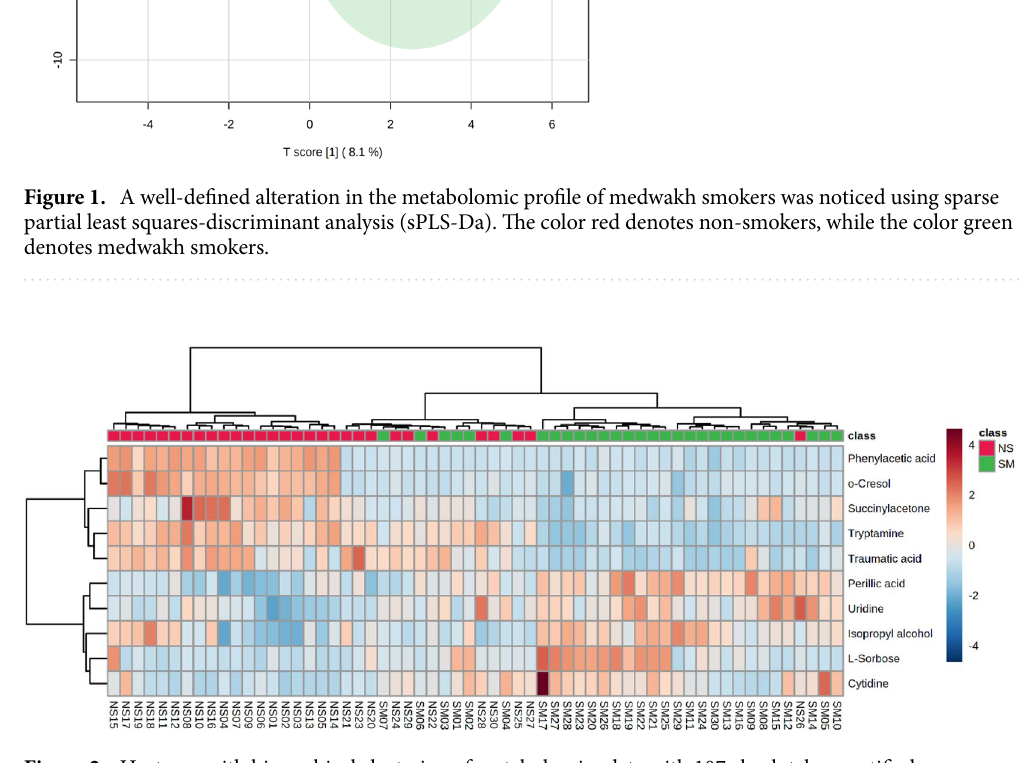
Figure 2. Heatmap with hierarchical clustering of metabolomics data with 107 absolutely quantified metabolites in the saliva samples of medwakh smokers and non-smokers. The heatmap was constructed with top 10 differential metabolites from the sparse partial least squared discriminant analysis